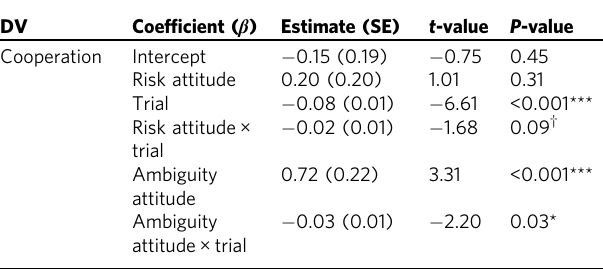
Table 1 Experiment 1: Risk and ambiguity attitudes in the Public Goods Game